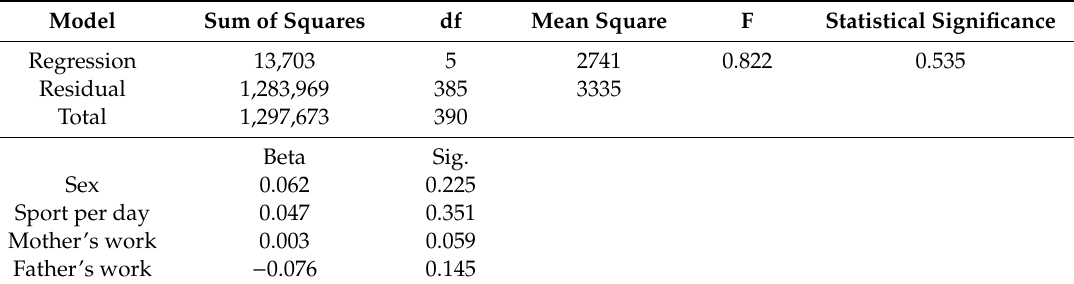
Table 4. Multivariate regression